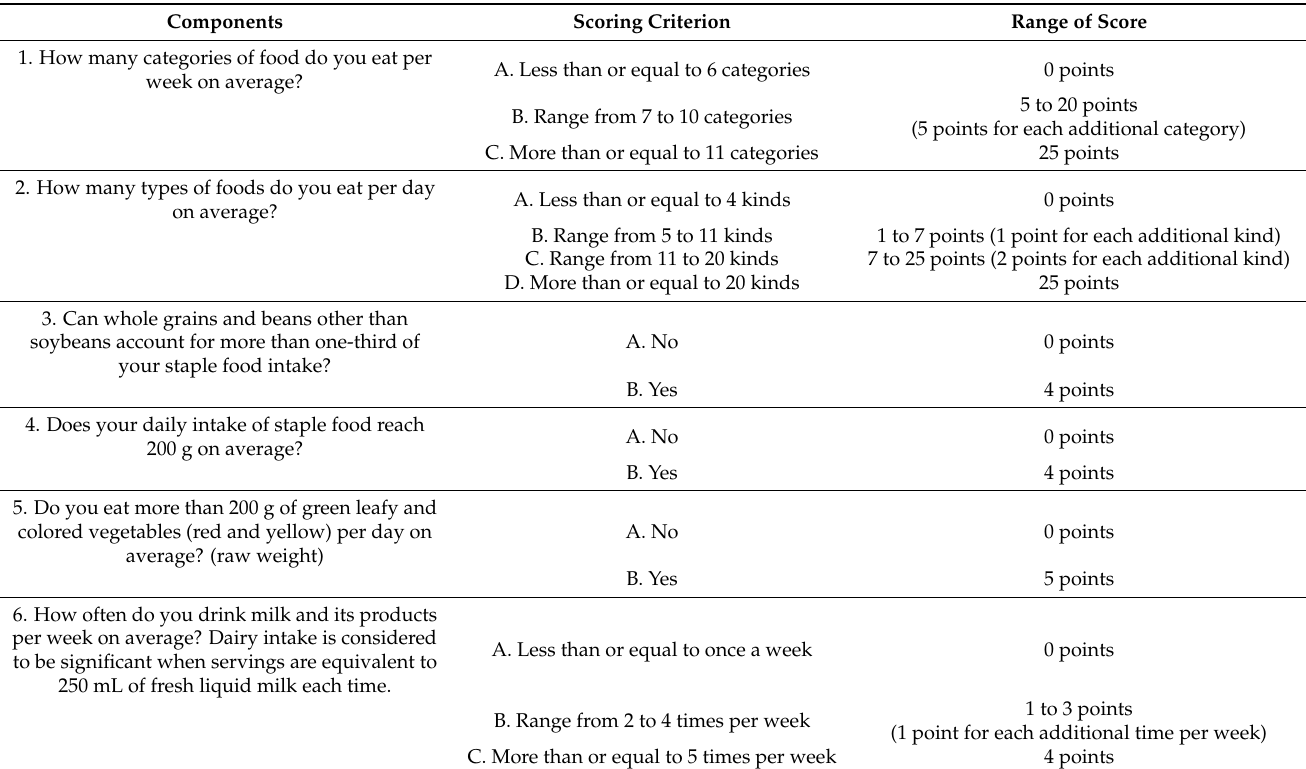
Table 2. Scoring criterion of